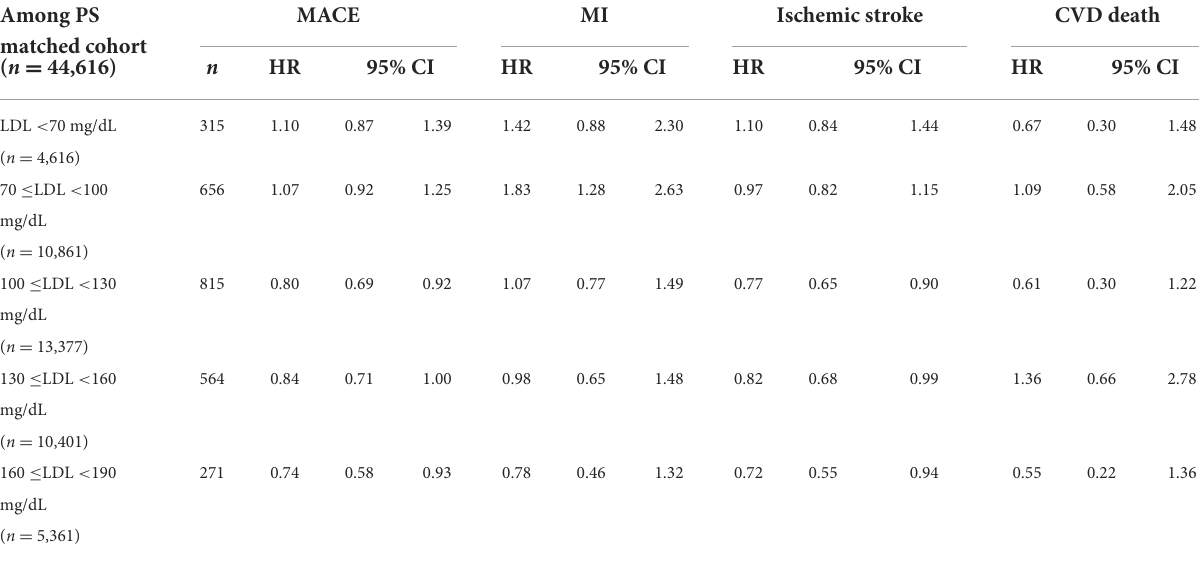
TABLE 5 Hazard ratio of MACE by LDL categories.